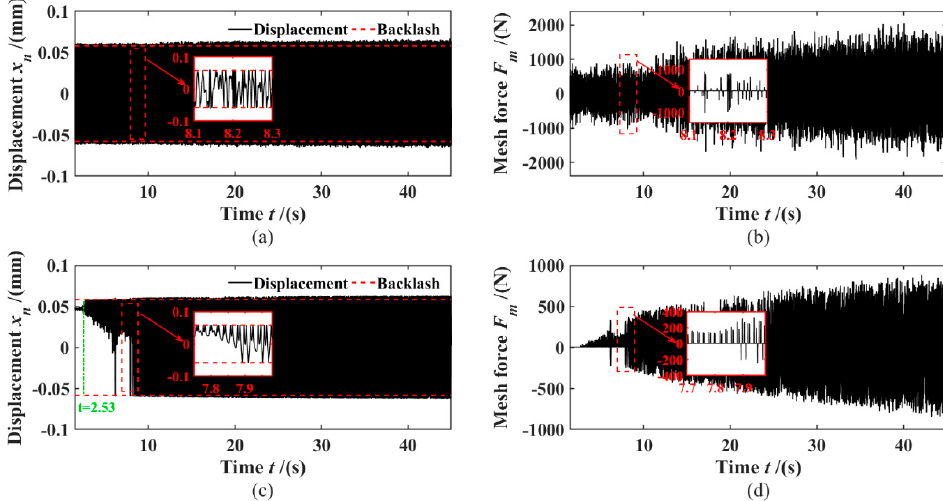
Figure 13. Dynamic response: ( a ) 4th gear relative displacement; ( b ) 4th gear meshing force; ( c ) 5th gear relative displacement; ( d ) 5th gear meshing